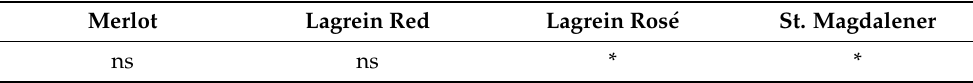
Table 6. Triangle test. ns: not significant; * significant ( α < 0.05). Merlot Lagrein